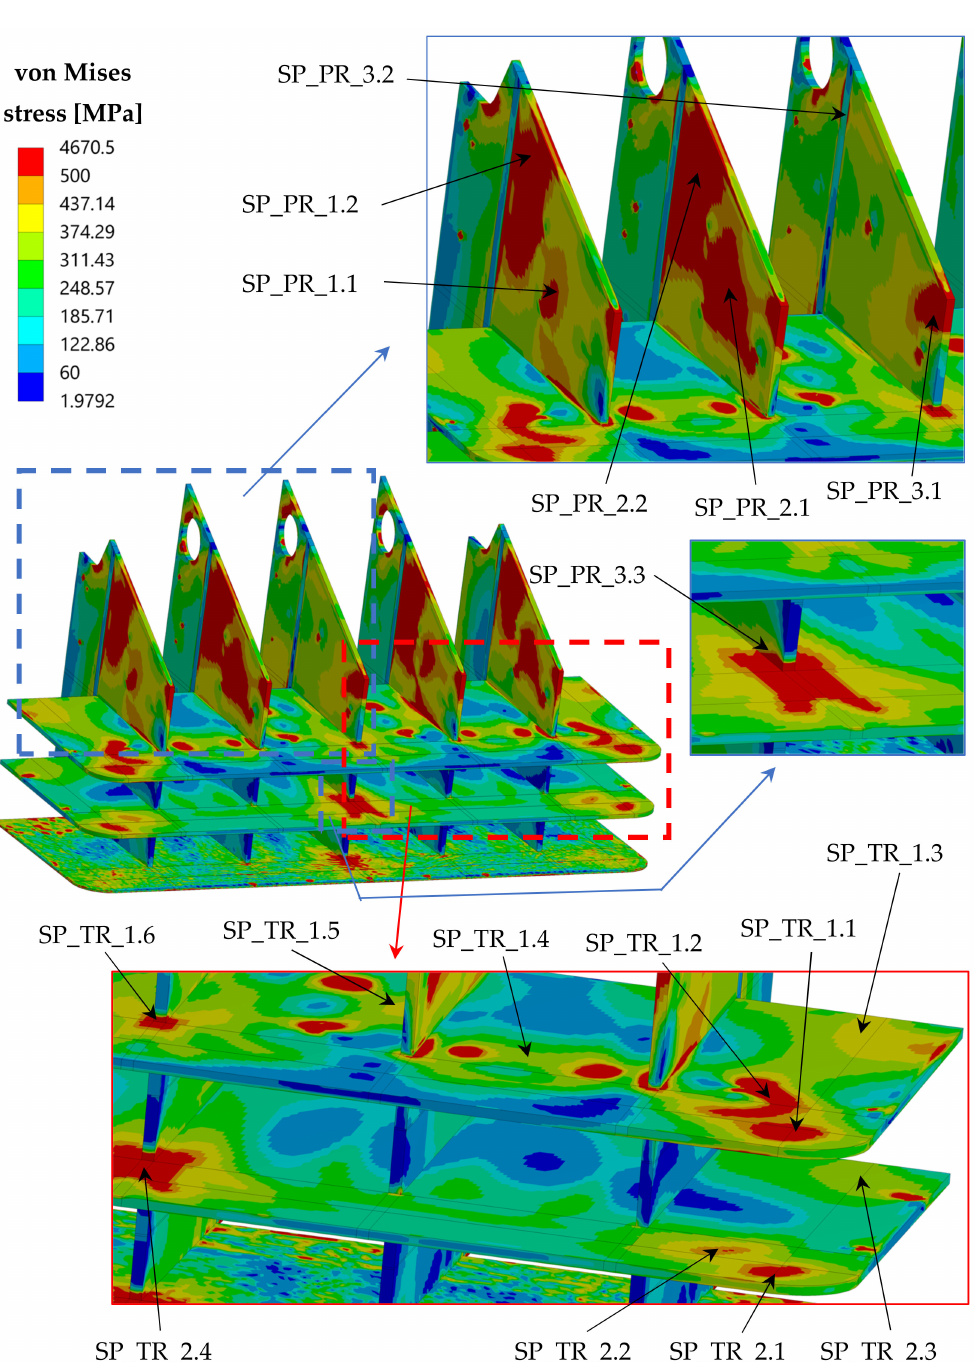
Figure 10. OP von Mises equivalent stress field and path locations within SPs